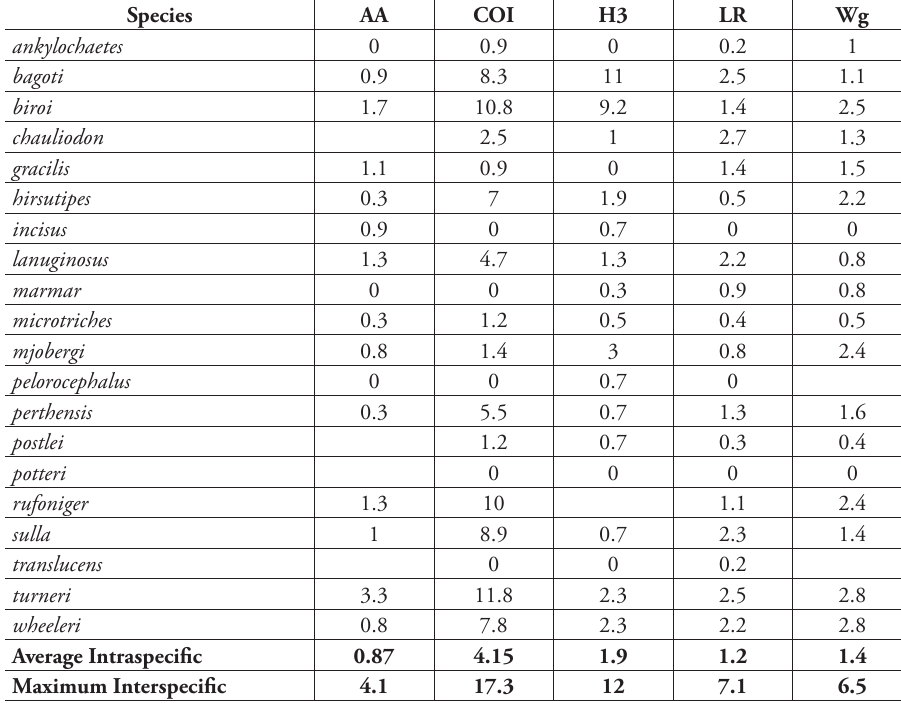
table 3. Maximum pairwise sequence divergence within species, for the five genes in this study. Blank cells indicate that only one specimen was sequenced for that gene-species